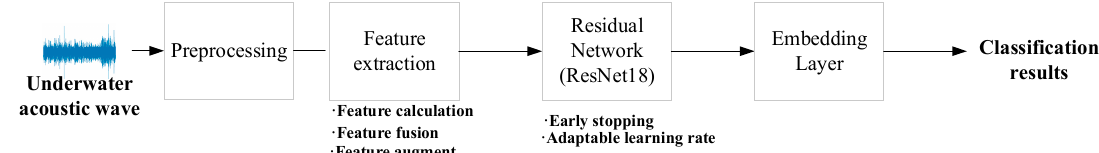
Figure 1. The depiction of the classification method.